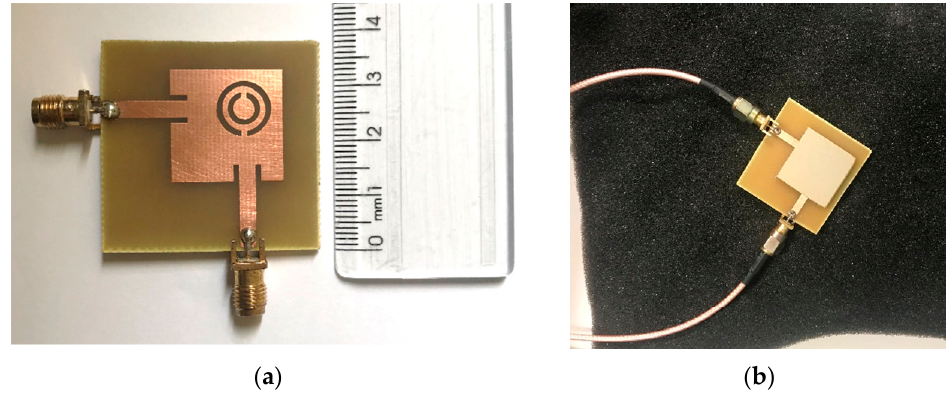
Figure 13. Photos of the ( a ) sensor prototype and ( b ) sensor geometry with an FR-4 MUT sample over the CSRR region.